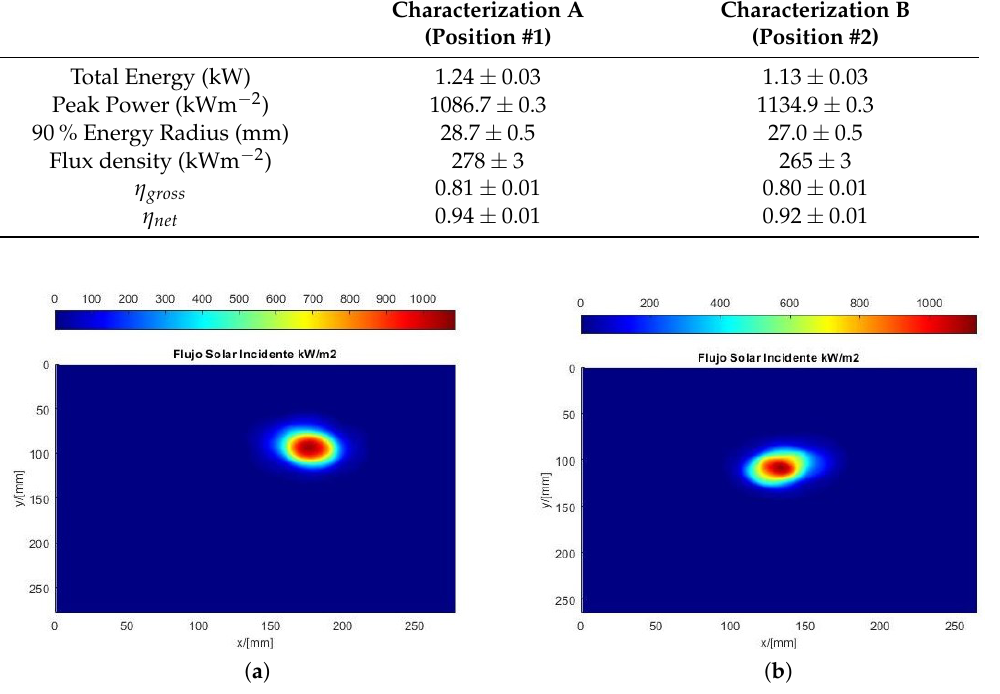
Figure 7. Solar flux distribution at focal plane for ( a ) position #1 (characterization A) and ( b ) position #2 (characterization